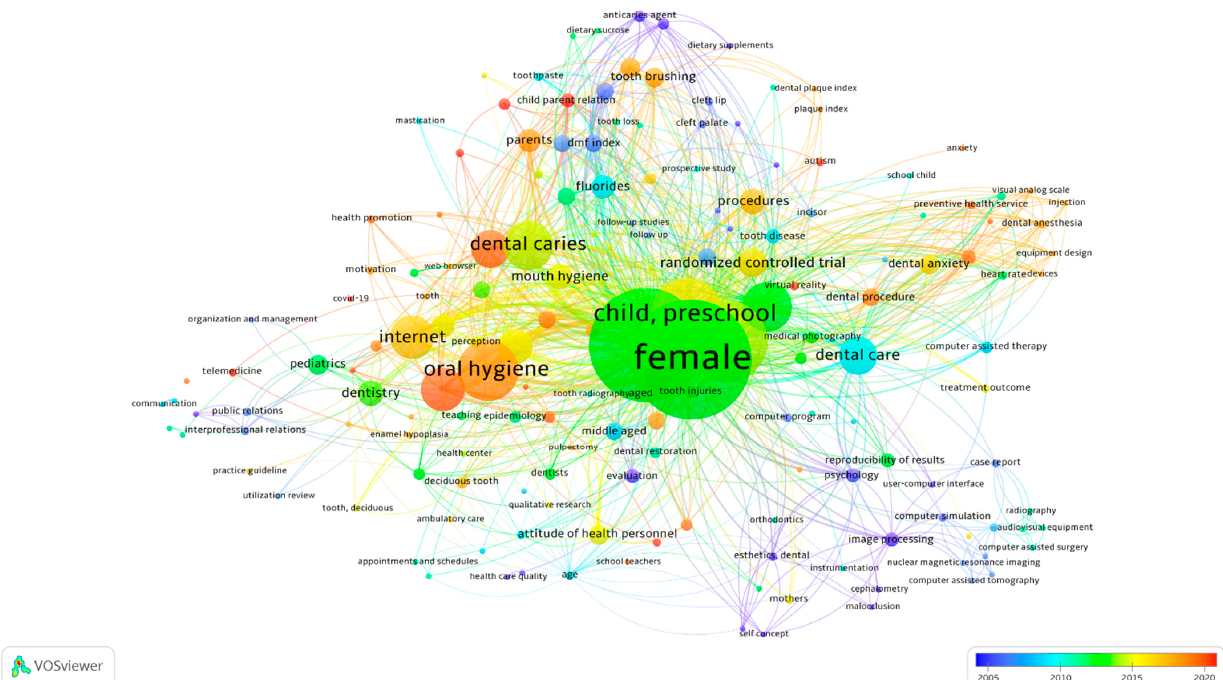
Figure 5. Overlay visualization map of the index keywords (keyword threshold = 2; displays 174 out of 559 keywords). Circles in dark and light blue and green represent those oral and dental related topics and digital technologies with an older average publication year. Circles in yellow, orange, and red demonstrate the terminologies with newer and more recent average publication year.